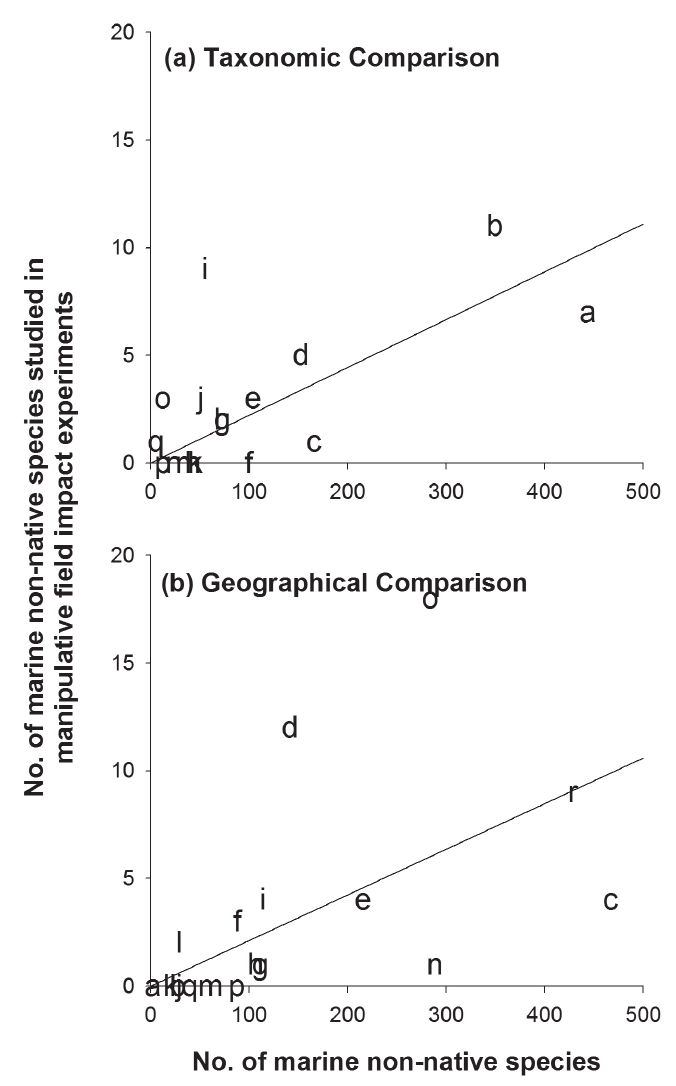
Figure 5. Marine invasion impact experiments classified according to a taxonomic identity of the non- native species and b invaded biogeographical regions. Graphs depict linear regression between manipula- tive marine field-based invasion impact studies against the total number of non-native and cryptogenic marine species , see manuscript text for regression data. Abbreviations (following Pyšek et al. 2008 and Hewitt and Campbell 2010); a : a = Arthropoda; b = Mollusca; c = Fish, d = Rhodophyta; e = Annelida; f = Cnidaria; g = Heterokontophyta; h = Ectoprocta; i = Chordata (minus fish); j = Green; k = Bacillariophyta; l = Por- ifera; m = Dinoflagellates; n = Platyhelminthes; o = Magnoliophyta; p = Protozoa; q = Echinodermata. b: a = Antarctica; b = Arctic; c = Mediterranean; d = NW Atlantic; e = NE Atlantic; f = Baltic Sea; g = Wider Caribbean; h = W Africa; i = S Atlantic Ocean; j = Central Indian Ocean; k = Arabian Sea; l = E Africa; m = E Asian Seas; n = S Pacific ocean; o = NE Pacific ocean; p = NW Pacific ocean; q = SE Pacific ocean; r = Australia & New